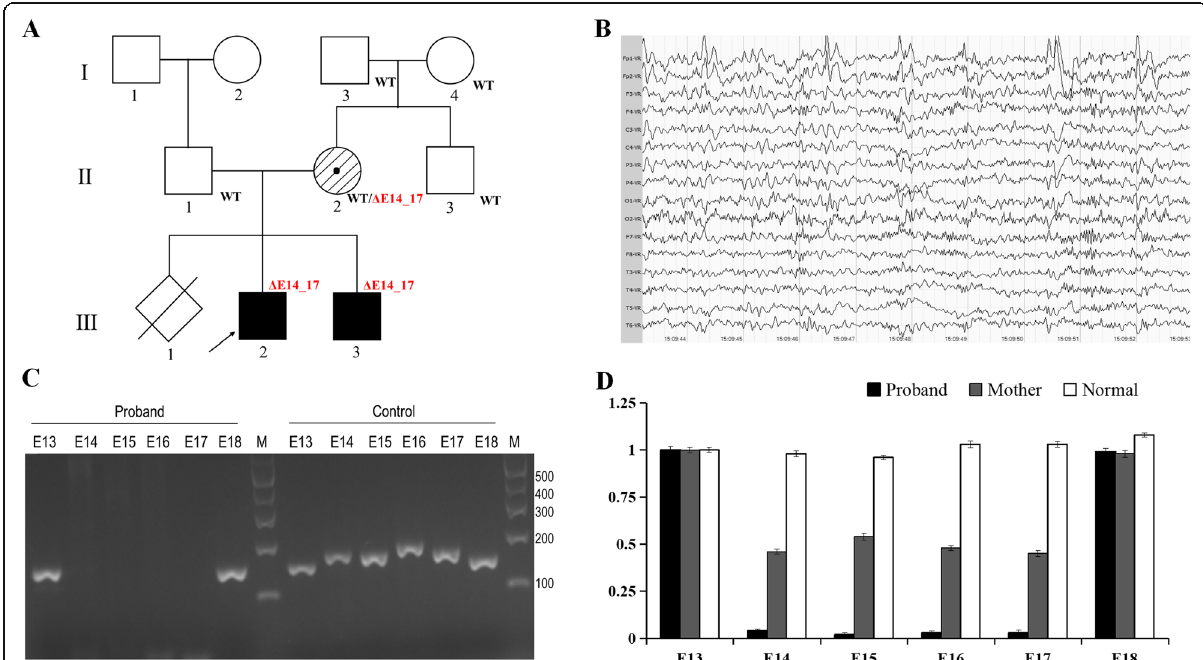
Fig. 1 a The mutation co-segregation in the pedigree. b Sleep – electroencephalography (EEG) showed that low-middle amplitude sharp waves and slow spike waves were distributed sporadically or continuously in the frontal and lateral temporal cortices during the interictal phase. c Exon 14 – 17 deletion in the proband was verified by PCR and agarose gel electrophoresis. PCR production for the exon 14 – 17 could not be detected in proband, but the adjacent exon 13 and 18 could be amplified. While the healthy control child gave products with expected sizes. d Exon 14 – 17 deletion was hemizygous in the proband, and heterozygous in the mother validated by quantitative realtime